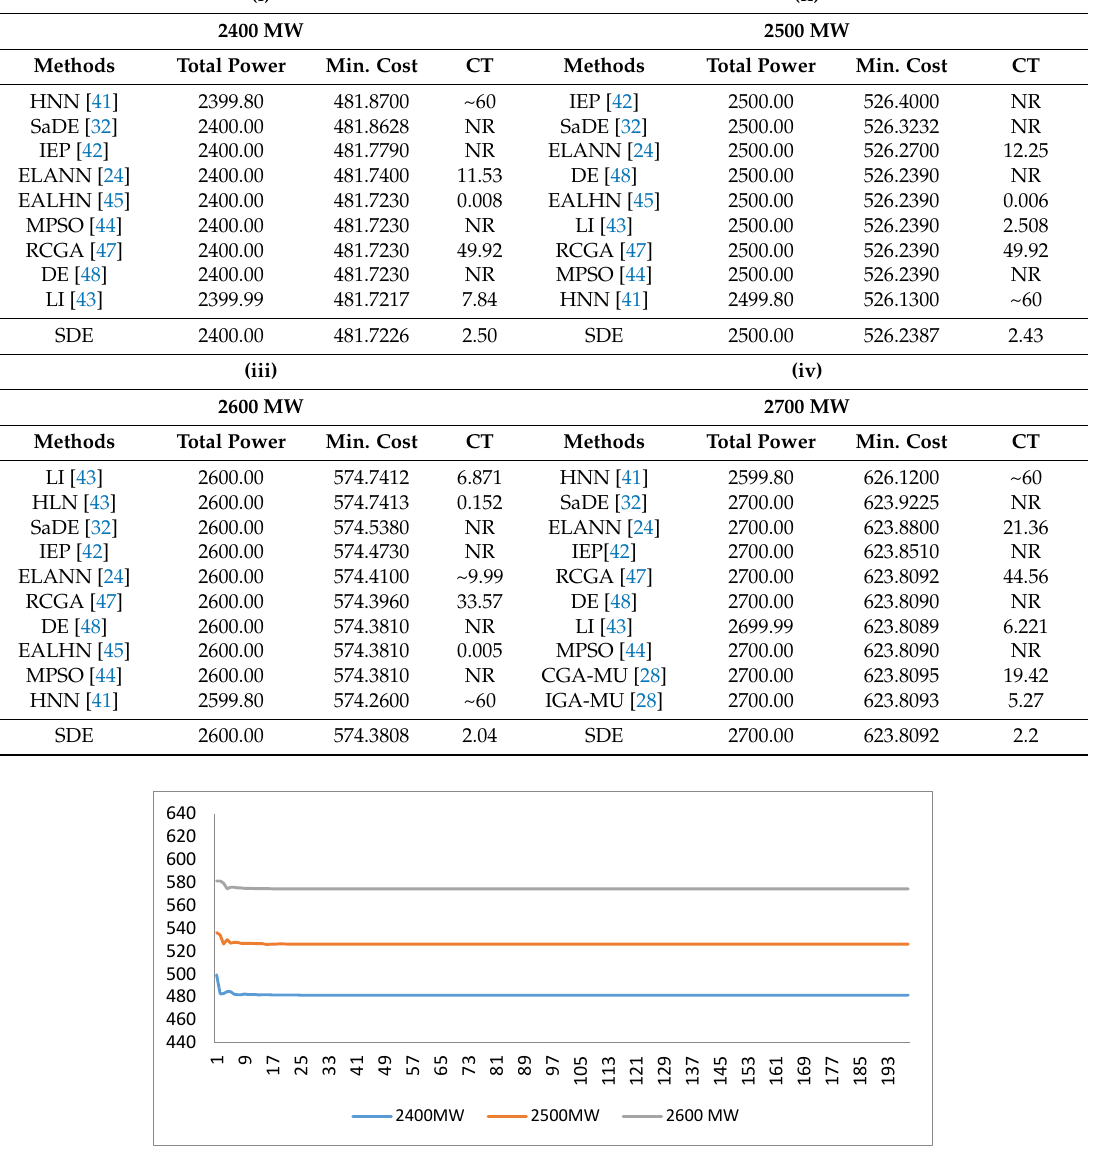
Figure 5. Convergence-characteristics of SBE algorithm for system 1 (without valve point loading effects), P d = 2400 MW, 2500 MW, 2600 MW.